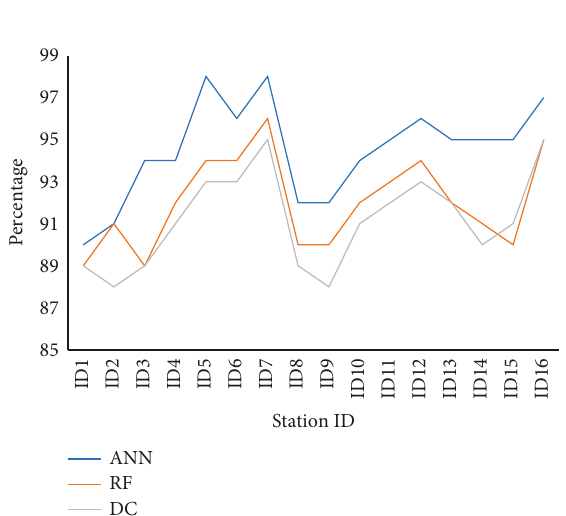
Figure 9: Precision of model for low passenger in each station.